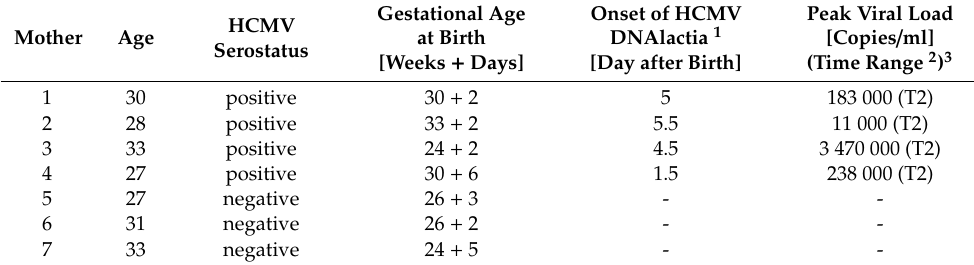
Table 1. Characteristics of the participating